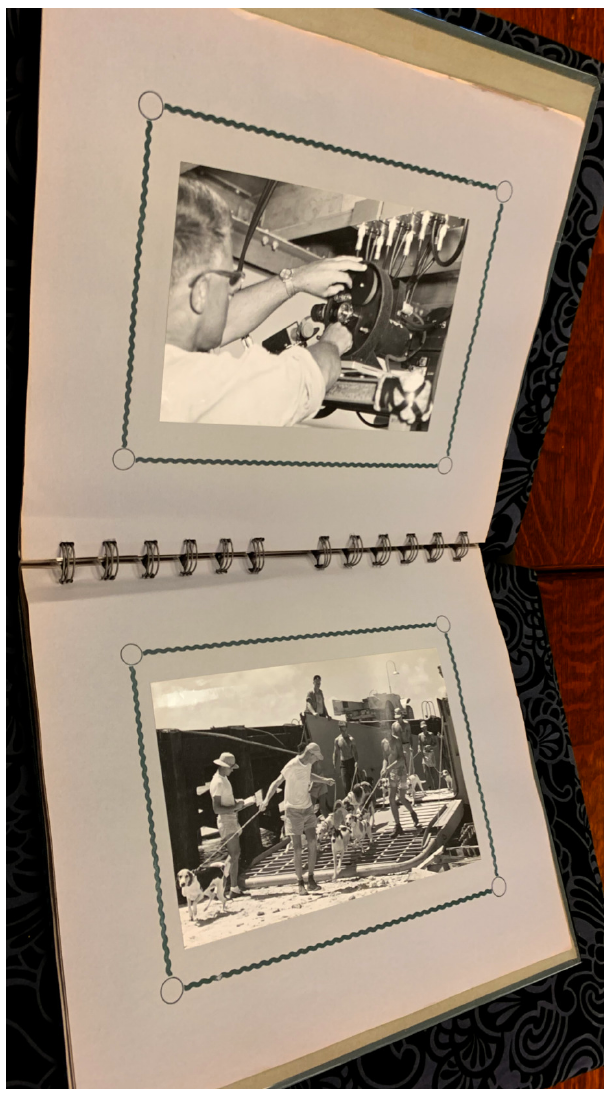
Figure 6: In facing pages of the Operation Greenhouse photo album, a photographer loads film into a camera ( left ), while workers unload dogs to be used as test subjects ( right ). Image courtesy of the Rare Book & Manuscript Library, University of Illinois at